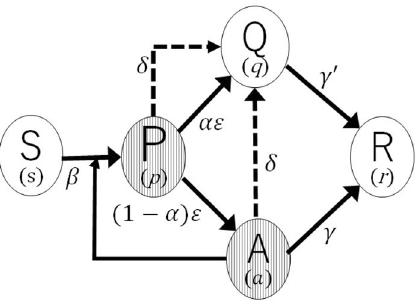
Figure 1. Schematic illustration of the SPAQR model for